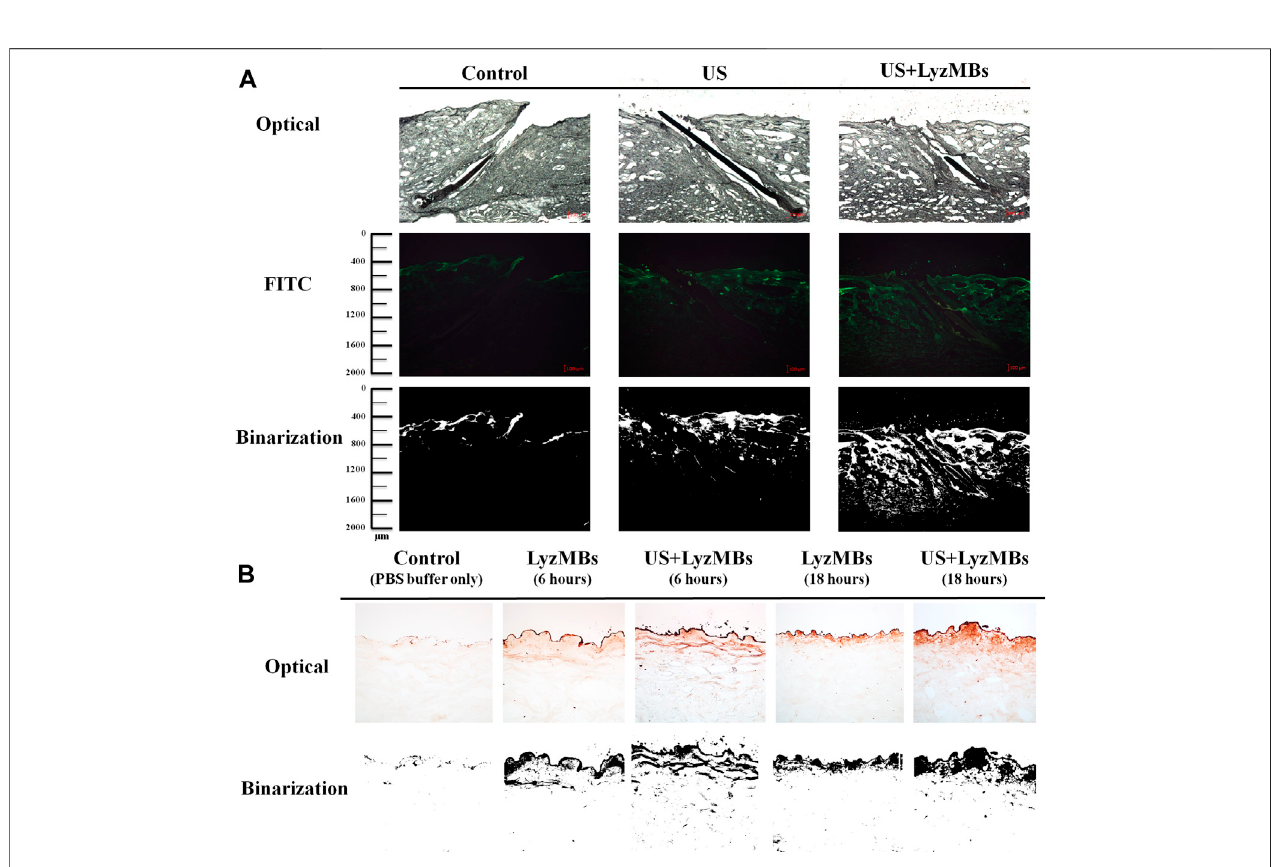
FIGURE 6 | (A) Bright - fi eld microscopy (upper panels) , fl uorescence microscopy (middle panels) , and binarization (lower panels) images of the model drug FITC in the control, US, and US+LyzMBs groups after the FITC solution had been present for 6 h (B) Results of enzyme immunohistochemistry of Lyz in pigskin after 6 and 18 h in the control, LyzMBs, and US+LyzMBs